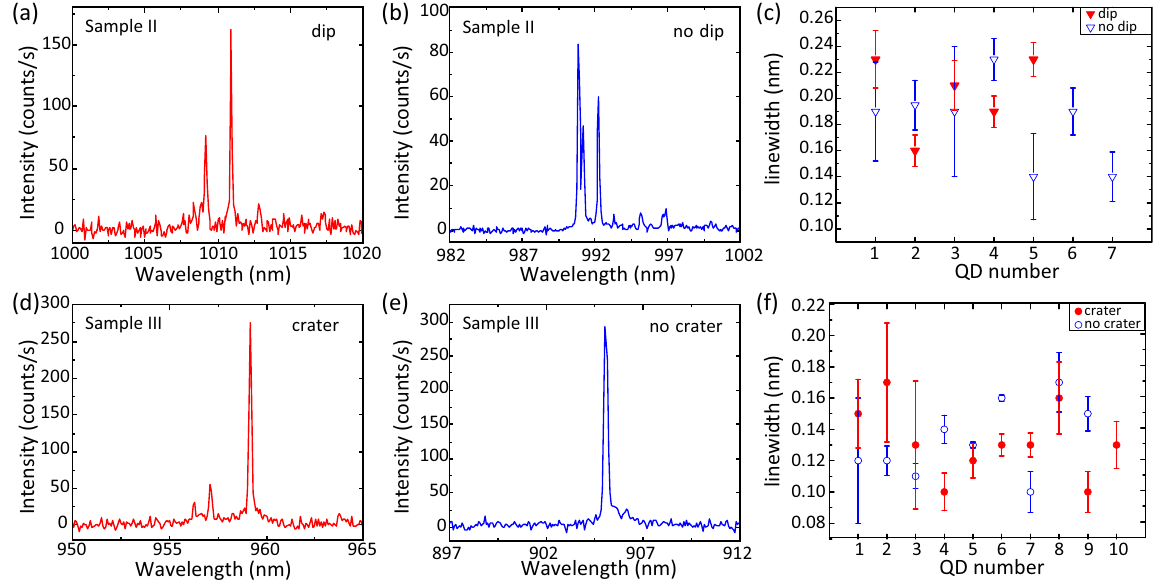
Figure 4. Comparison of the spectral linewidths measured from quantum dots found in correspondence to surface morphological features and smooth surfaces. ( a ) and ( d ): Photoluminescence spectra, collected under non-resonant laser excitation at a temperature of 4 K, from single QDs aligned with surface features [dip-like (Sample II) in ( a ) and crater-like (Sample III) in ( d )]. ( b) and ( e ): Photoluminescence spectra from single QDs, collected from the same samples as the corresponding spectra in ( a ) and ( d ), but from areas not showing any surface features. ( c ) and ( f ): Linewidths, extracted from Lorentzian fits of single emission lines measured in photoluminescence spectra like the ones shown in panels (a), (b), (d), and (e), of QDs found in correspondence to morphological features (filled red symbols) and to smooth surfaces (open blue symbols). The error bars are obtained from one standard deviation uncertainties in the Lorentzian